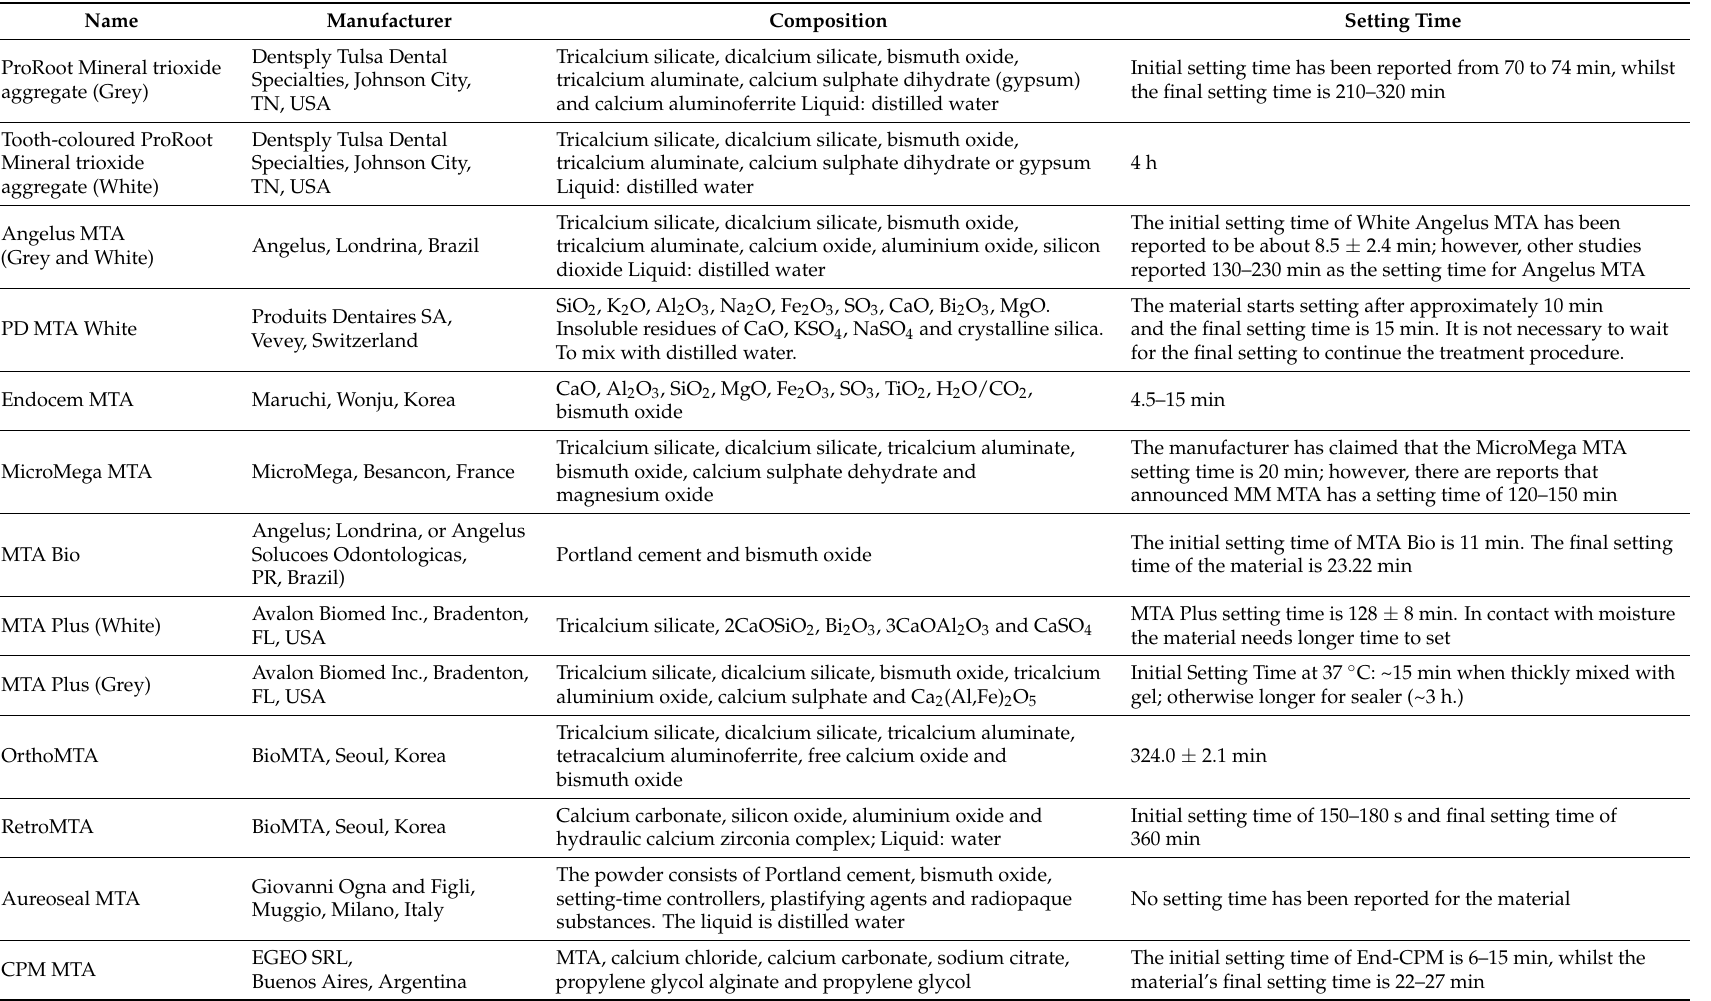
Table 1. MTA materials commercially